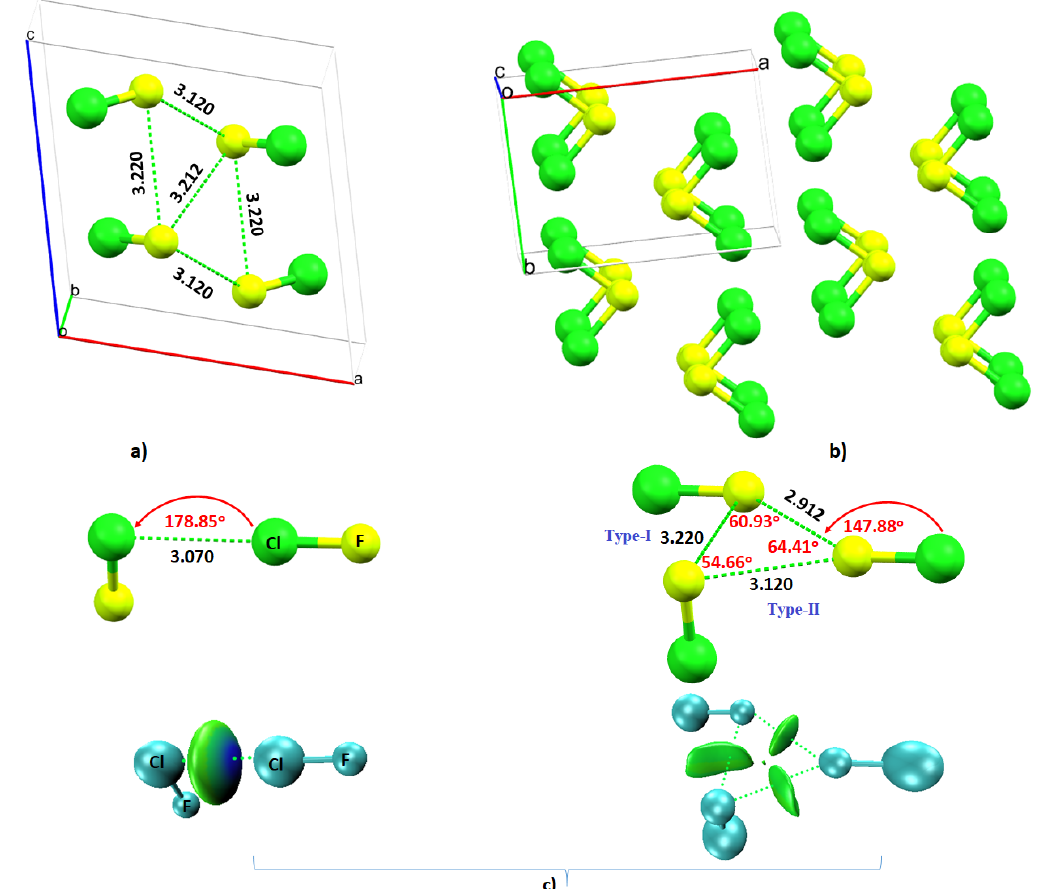
Figure 14. The ball-and-stick models of chlorine monofluoride (ClF) crystal (CSD ref: YATKOV): ( a ) Unit cell and ( b ) 2 × 2 supercell. ( c ) Possible bonding modes identified between halogen that emerged from an IGM analysis atoms are illustrated as isosurfaces in green and mixed blue-green.